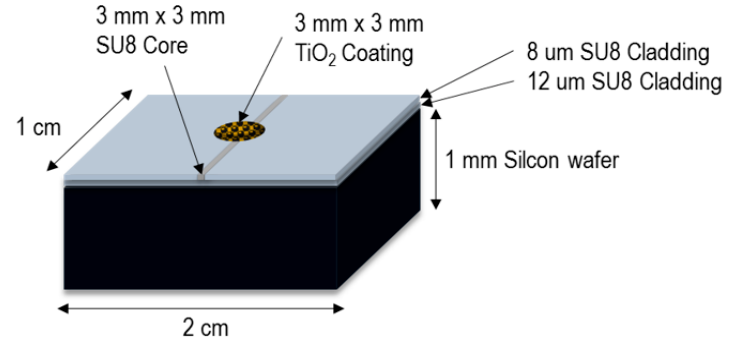
Figure 2. Dimention and structure of the fabricated device.